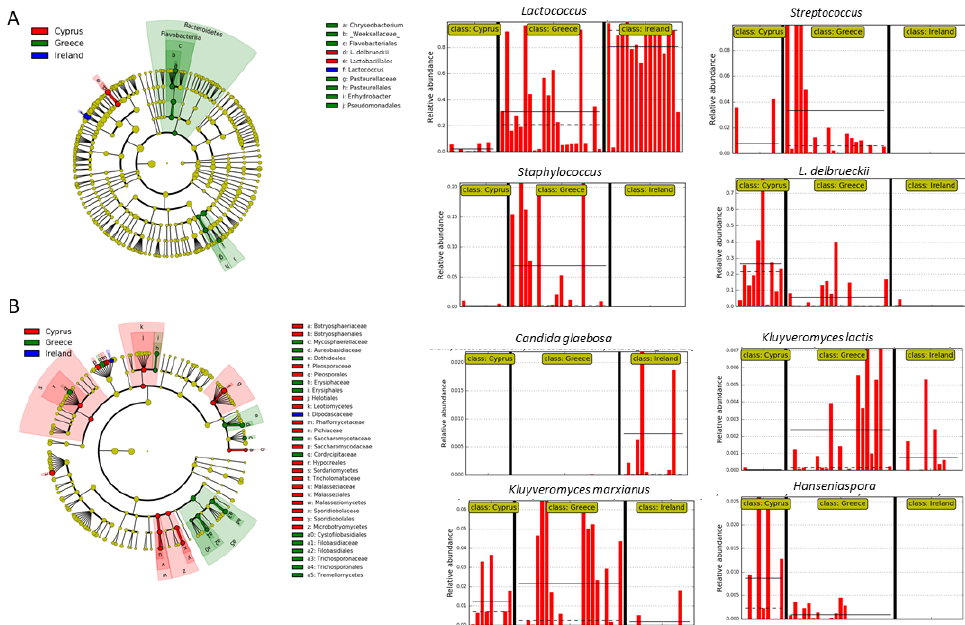
Figure 6. Biomarkers discovery using the LEfSe algorithm showing ( A ) bacterial and ( B ) fungal taxa that indicated statistically significant over-representation among the Irish, Greek, and Cypriot cheeses, based on a non-parametric factorial Kruskal–Wallis (KW) sum–rank test, an (unpaired) Wilcoxon rank–sum test, and LDA. The left part of the picture depicts phylogenetic trees that map the taxonomic differences of the detected biomarkers from class (outside part of the circle) to species level (inside part of the circle), combined with a list of taxa with significantly increased representation in cheeses from Cyprus (red color), Greece (green color), and Ireland (blue color). The right part of the picture shows histograms of the taxa that indicated significantly increased relative representation in cheeses from Ireland, Greece or Cyprus, their detected relative abundances, and in how many samples they were detected.